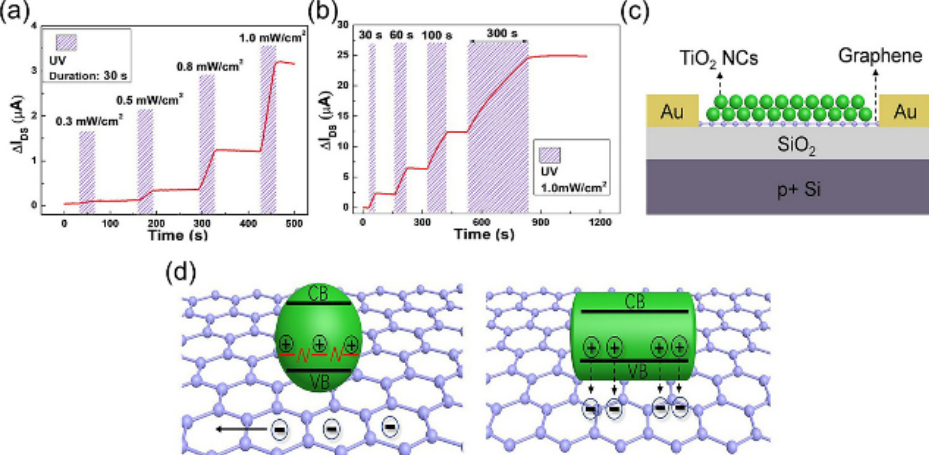
Figure 10. N-TiO 2 device instantaneous photocurrent response to UV light ( a ) with different Ee values or ( b ) with different durations. ( c ) Schematic of a N-TiO 2 device. ( d ) Schematic diagram of hole storage in N-TiO 2 NC (green spheres) and schematic diagram of hole recombination in commercial TiO 2 NC (green rods) with electrons in graphene after UV irradiation. Reproduced with permission from Ref. [75]; published by the American Chemical Society, 2020.